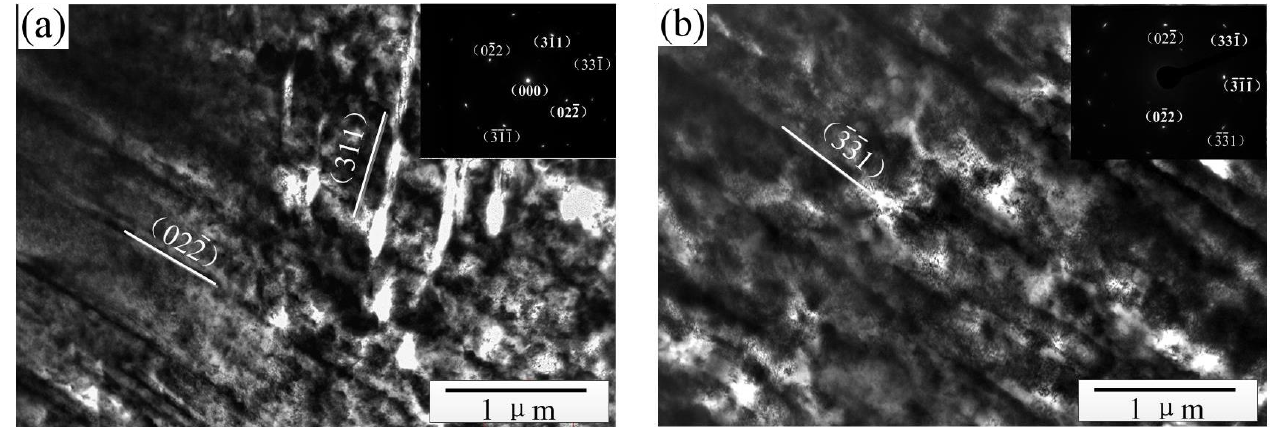
Figure 8. Fault structure of cold rolled strip (ε = 50%). ( a ) EG strip and ( b ) CG strip.